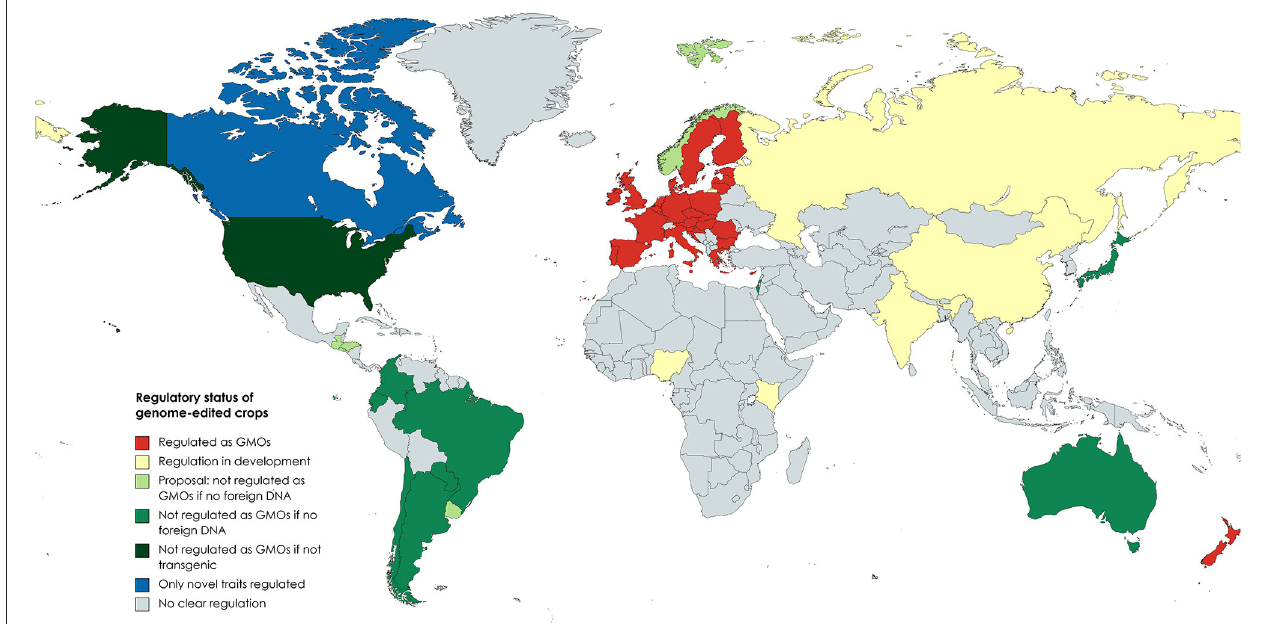
FIGURE 3 | Regulatory status of genome-edited